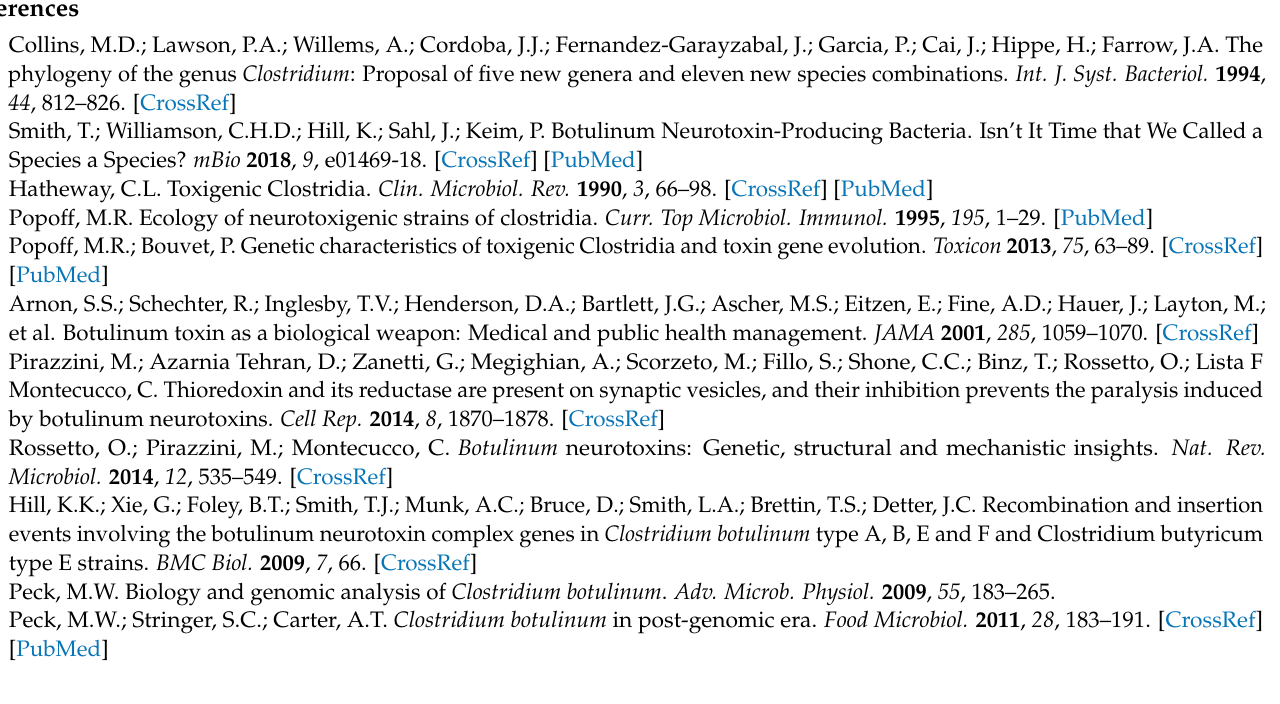
Figure S1: Graphical representation of the alignment between sequences of plasmid categories PG10 and PG20. Figure S2: Graphical representation of the alignment between sequences of plasmid categories PG7 and